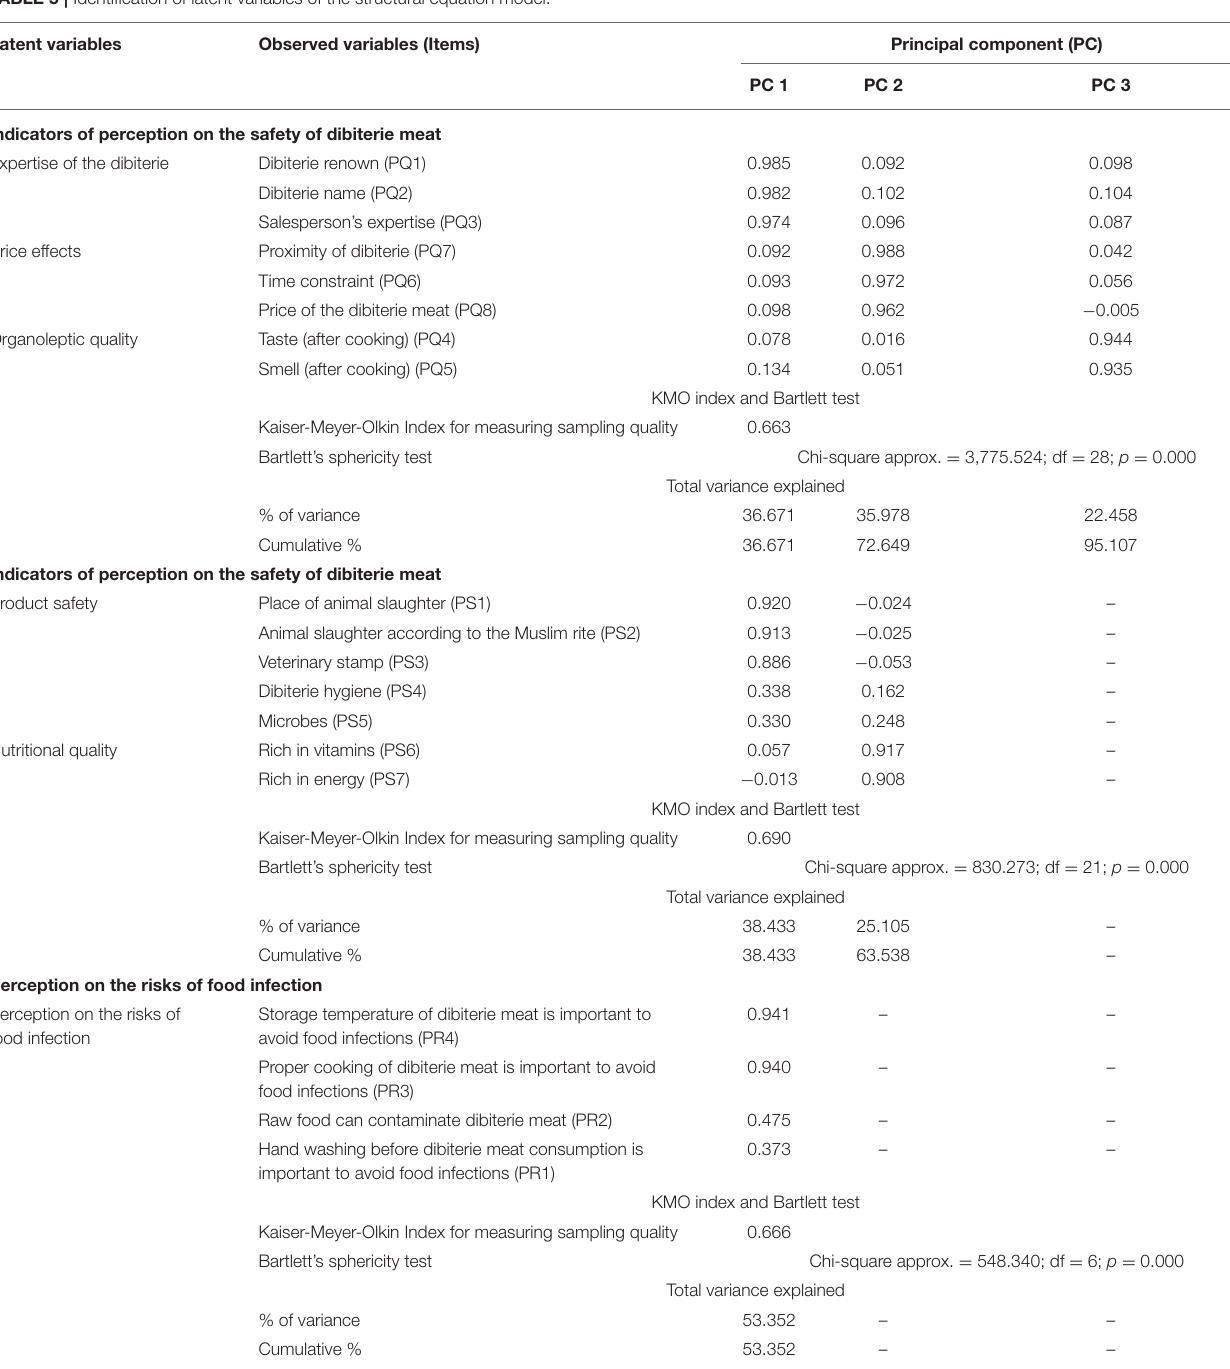
TABLE 5 | Identification of latent variables of the structural equation